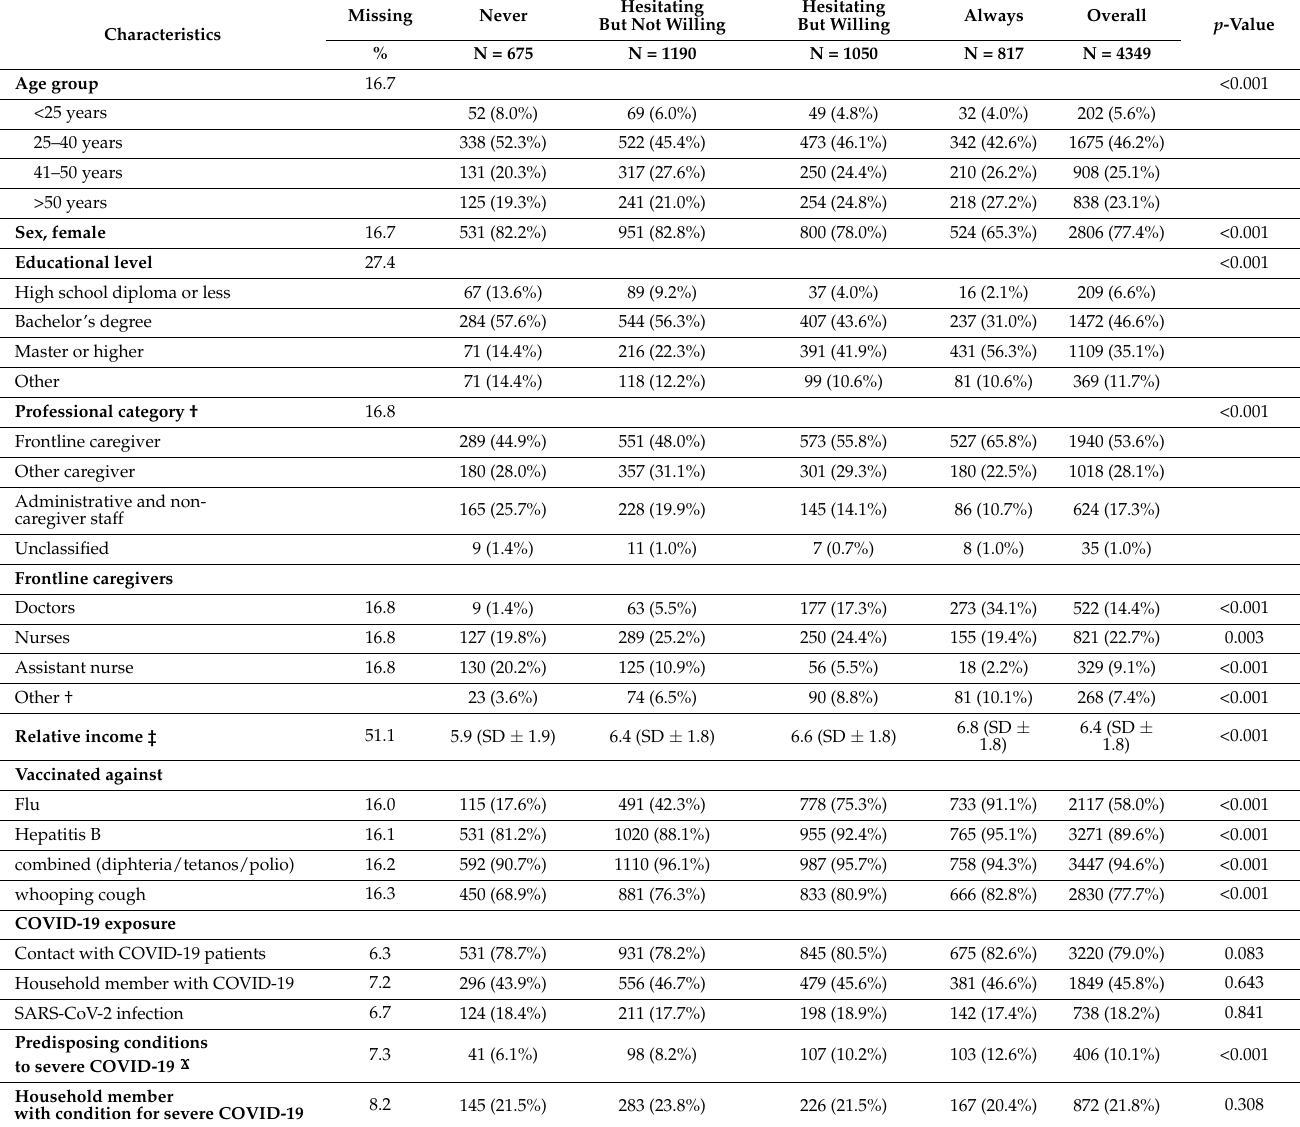
Table 1. Characteristics of respondents by cluster.